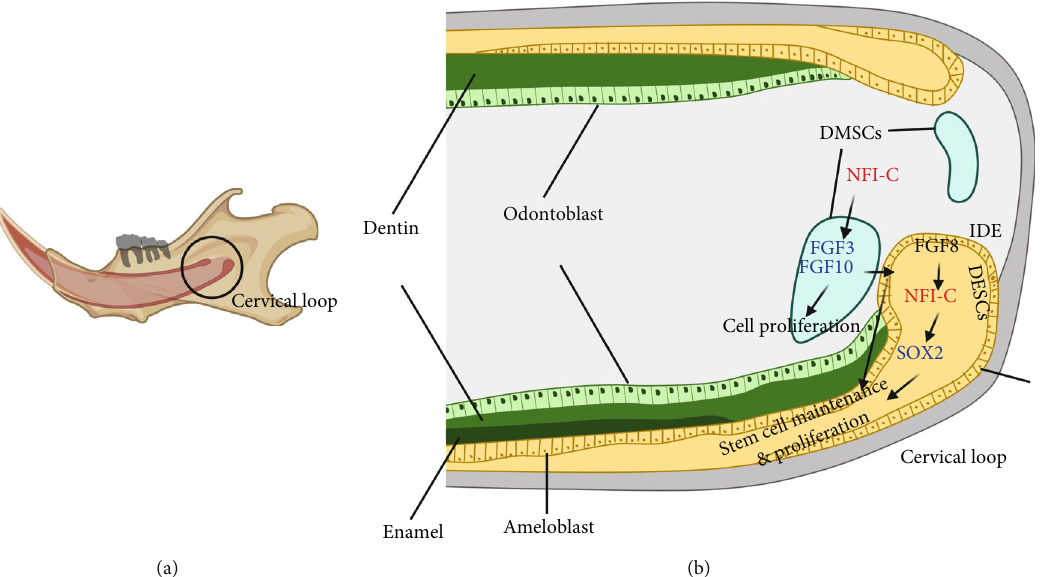
Figure 8: Schematic diagram demonstrating the signaling pathway in the context of ectomesenchymal interaction for maintenance and proliferation of DESCs in mouse incisor cervical loop. N fi c is involved the cell proliferation and maintenance of DESCs in two di ff erent pathways. Within the dental epithelium, it mediates FGF8-NFIC-SOX2 signaling pathway. In the dental mesenchymal stem cell, N fi c induces FGF10 which controls the proliferation of dental epithelial stem